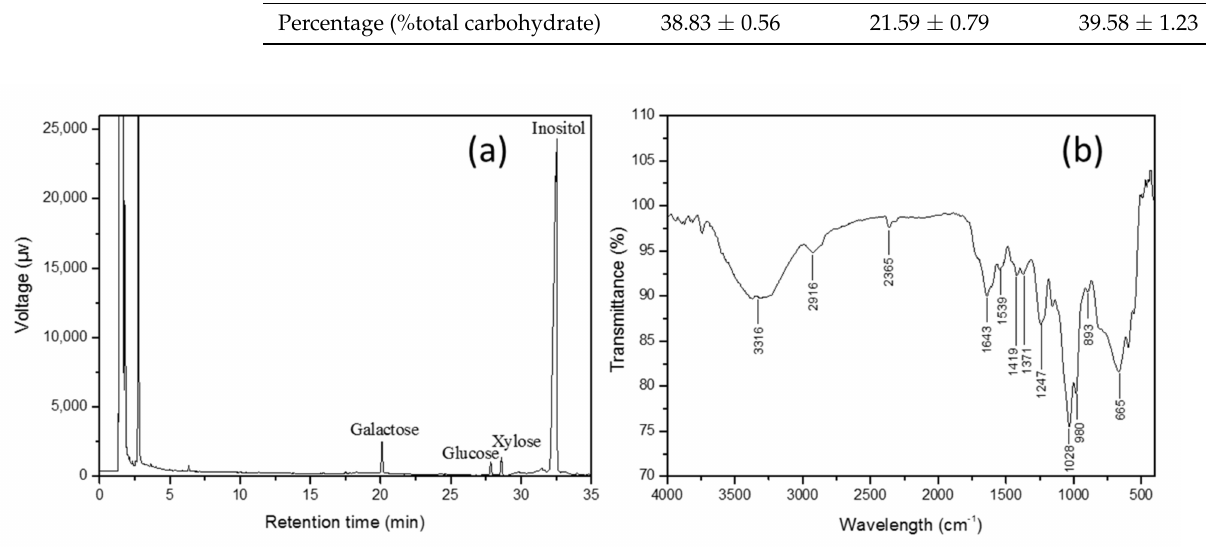
Figure 5. Characteristics of semi-refined polysaccharides in Porphyridium purpureum . ( a ) Monosaccharide composition and ( b ) Fourier infrared spectra.